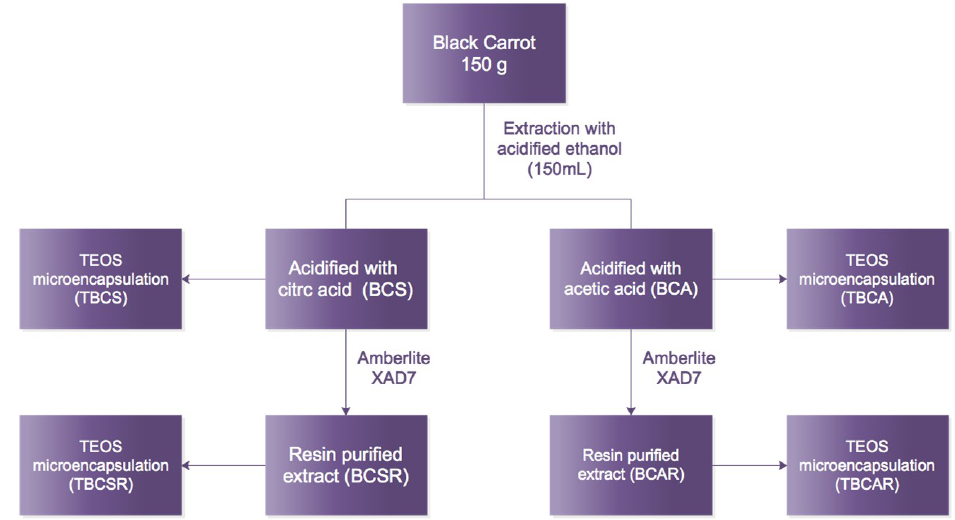
Figure 9. Flow diagram of experimental processes for obtaining samples. Samples extracted with ethanol/citric acid (BCS) and ethanol/acetic acid (BCA), samples after resin column (BCSR and BCAR), and microencapsulated samples using TEOS (TBCS, TBCA, TBCSR, TBCAR).